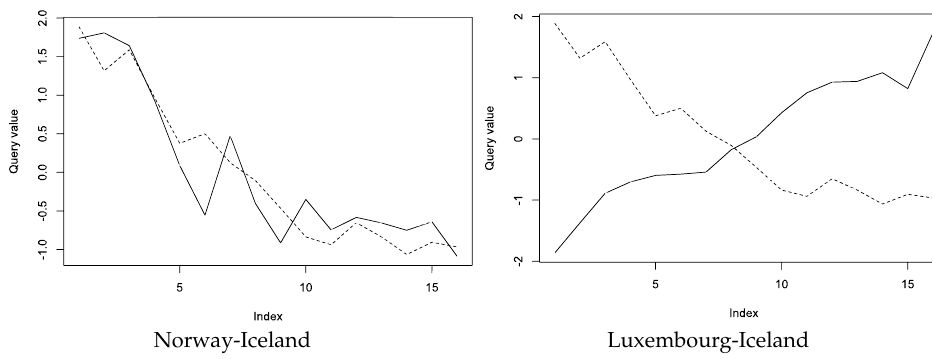
Norway and Luxembourg are marked with solid lines and Iceland is marked with a dashed line. Figure 2. Two-way alignment plots for Norway-Iceland and Luxembourg-Iceland. Source: own elaboration .